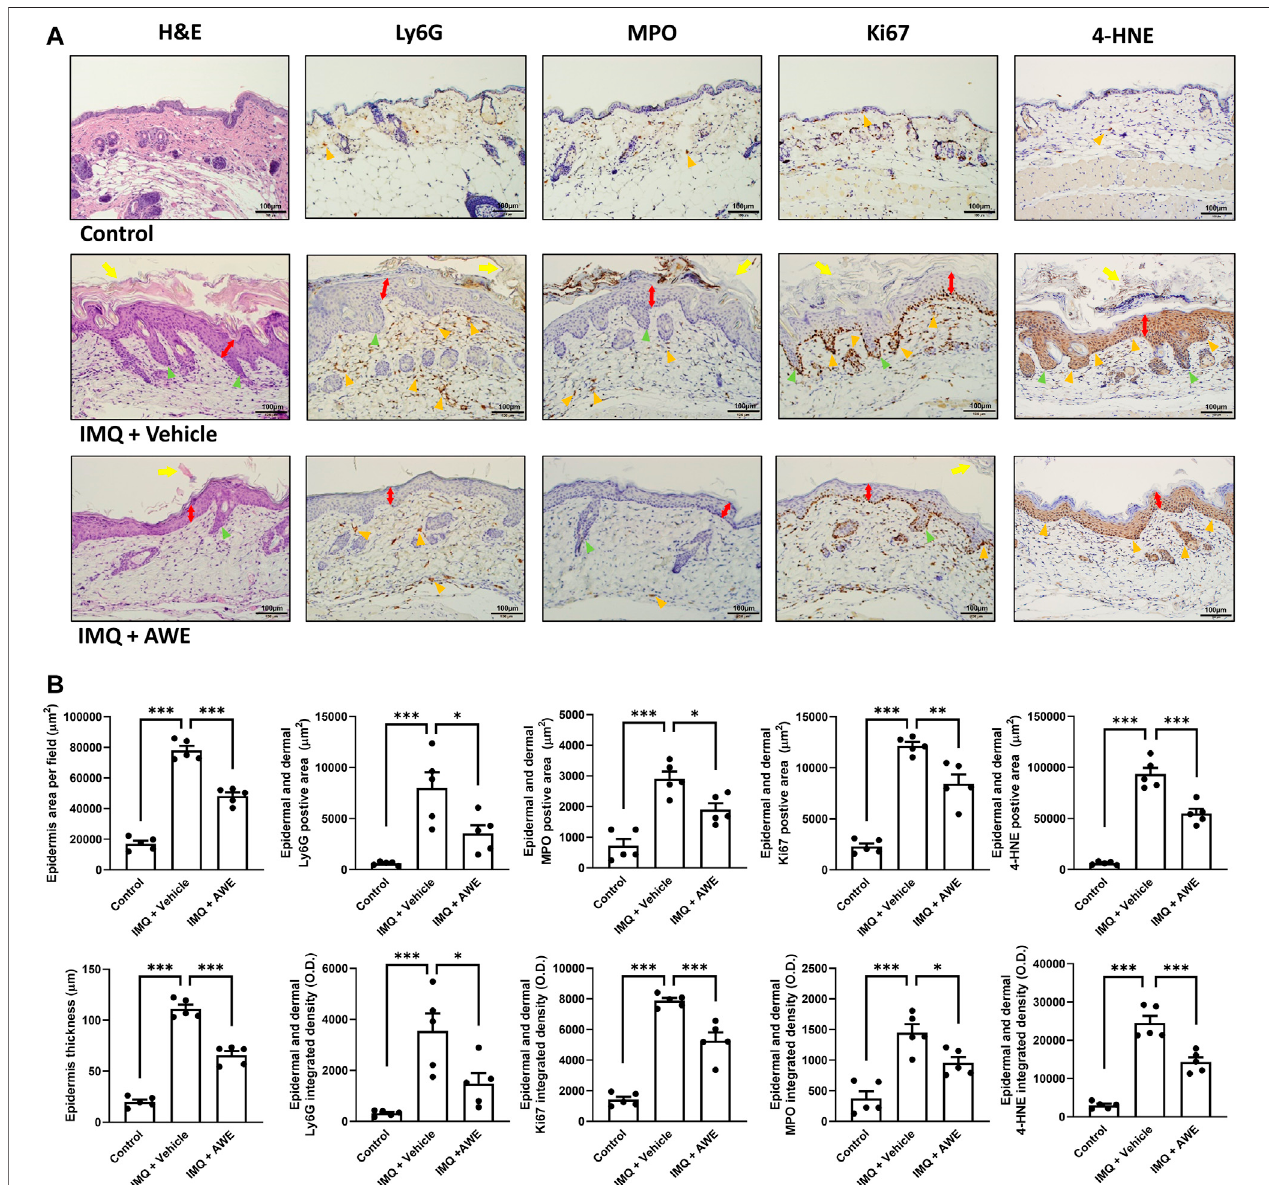
FIGURE 9 | AWE reduced the epidermal thickness and neutrophil in fi ltration in IMQ-induced psoriasis-like skin in fl ammation in mice. The mice were sacri fi ced by deepanesthesiaonday6aftertopicalIMQandAWEorvehicletreatmentfor5 days.Theirbackskinswerecollectedandstoredin4%formaldehyde.Hematoxylin-eosin (H&E) staining and immunohistochemical (IHC) staining for Ly6G, MPO (the neutrophilin fi ltration and activation marker), Ki67 (the epidermal proliferation marker), and 4- HNE (the ROS marker) were performed for all samples (marked as orange triangles). The representative images (A) were observed under a microscope. The scale bar was 100 μ m. The IMQ plus vehicle group exhibited psoriasis-like skin in fl ammation. The typical histological manifestations are marked as yellow arrows (hyperkeratosis), double-sided red arrows (acanthosis), and green triangles (elongation of rete-like ridges). AWE signi fi cantly decreased neutrophil in fi ltration and epidermal thickness in IMQ-induced psoriasis-like skin in fl ammation in mice. (B) The quanti fi ed image data using ImageJ. Epidermal area and average epidermal thickness were calculated in H&E staining. Ly6G-, MPO-, Ki67-, and 4-HNE-positive area and integrated density were calculated in IHC staining. Data are expressed as mean S.E.M. ( n (cid:2) 5). Statistical analysis was conducted using the one-way analysis of variance (ANOVA), followed by Tukey ’ s multiple comparison test if there were statisticaldifferencesintheresultsofANOVA.Adjusted p -valuesofTukey ’ smultiplecomparison tests werede fi ned as*** p < 0.001,** p < 0.01,and* p < 0.05compared with the IMQ plus vehicle